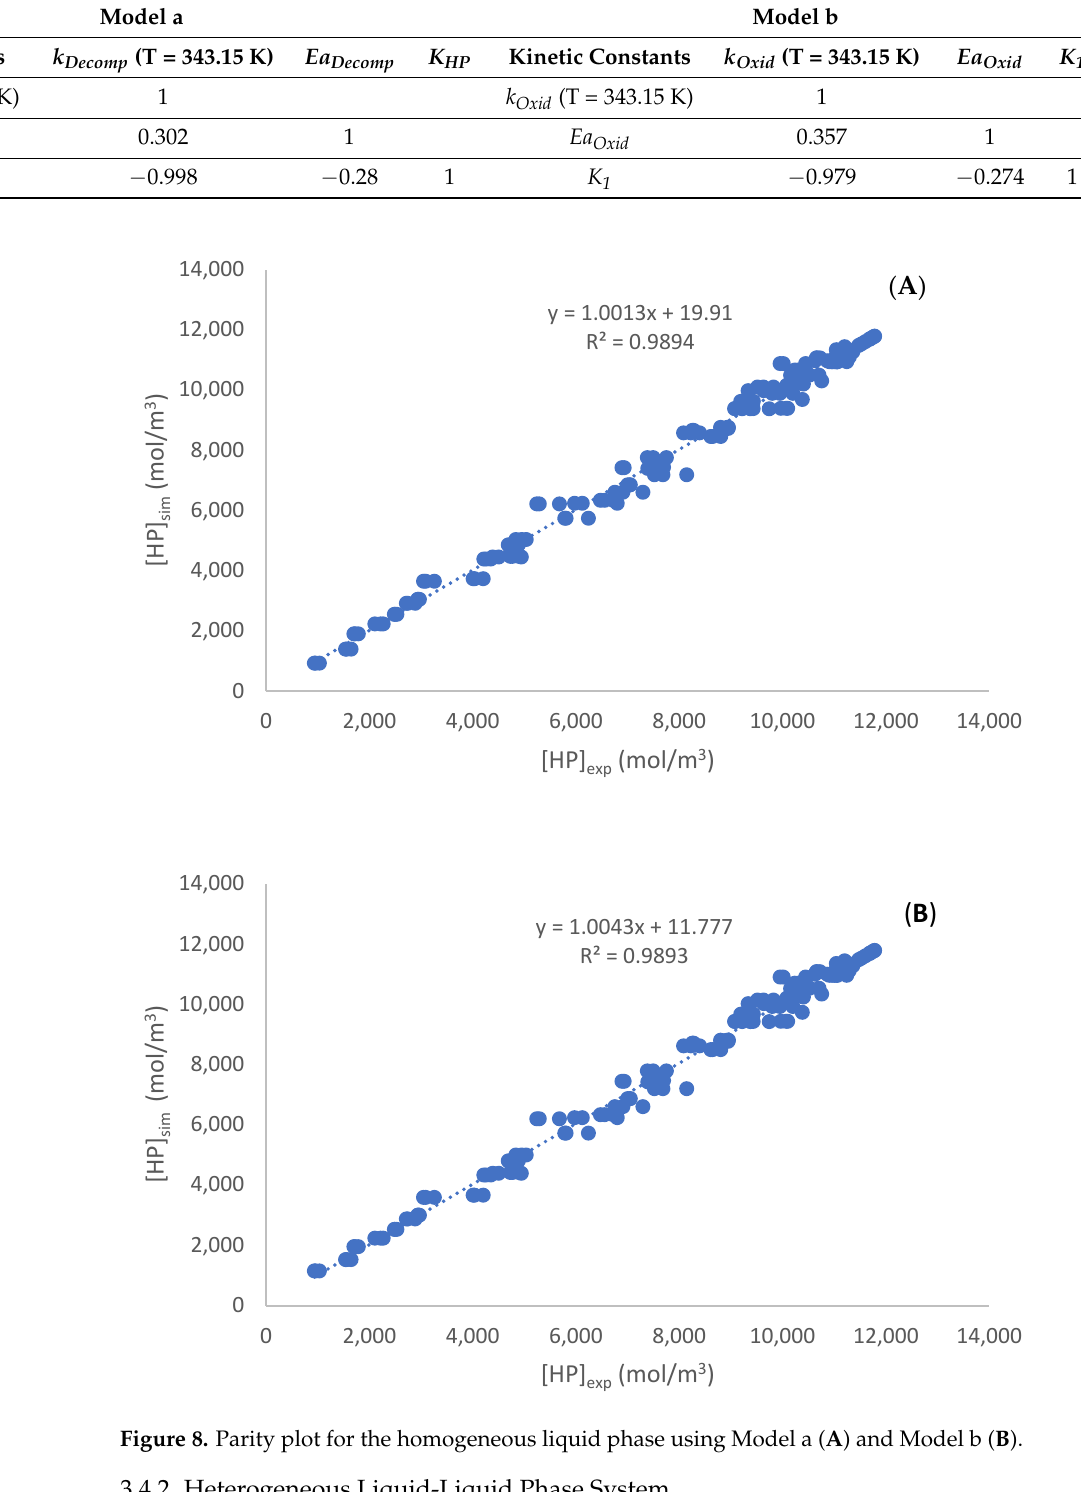
Figure 8. Parity plot for the homogeneous liquid phase using Model a ( A ) and Model b ( B ).